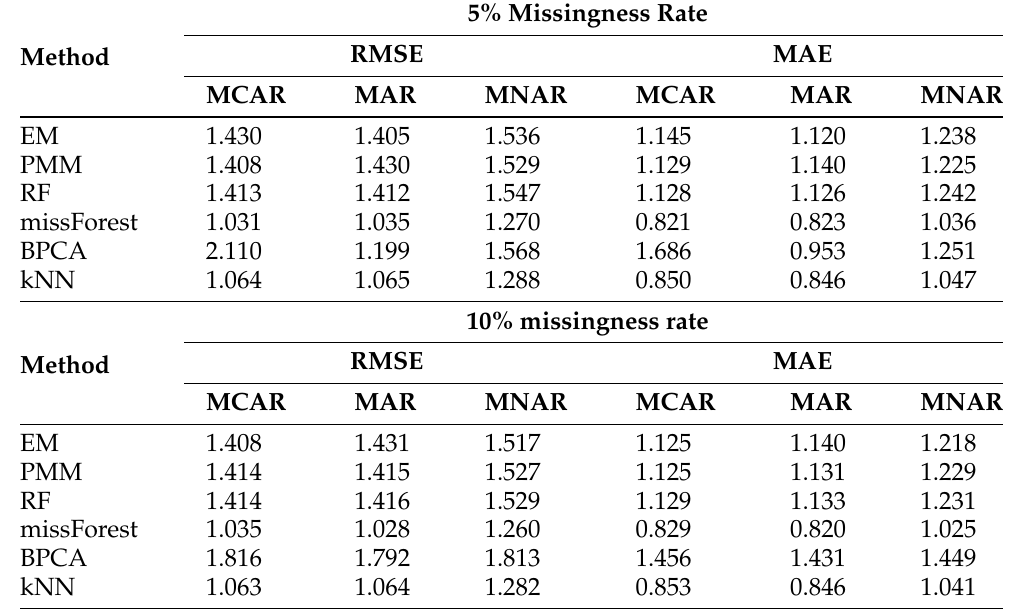
Table 5. RMSE comparison between the indexed original values and the imputed values using missing at random (MAR), missing completely at random (MCAR) and missing not at random (MNAR) missingness patterns. From the results, it is very obvious that the MAR technique has the lowest RMSE scores among the other techniques. We can also see that missForest had the lowest RMSE and MAE, among the other imputation methods, for all missing rate